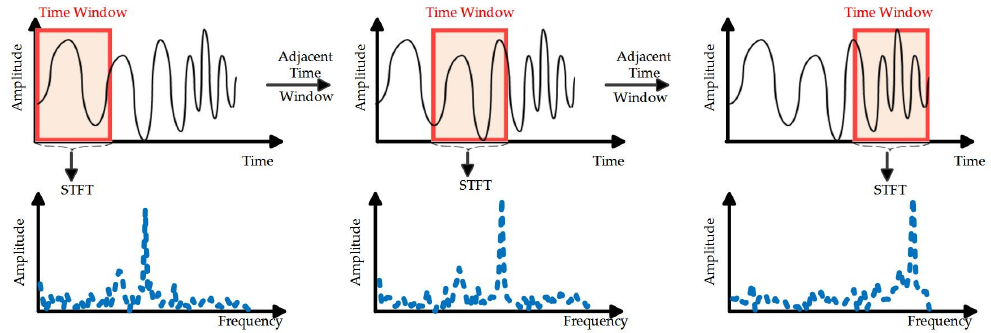
Figure 4. Short-Time Fourier Transform (STFT) sliding time window method.